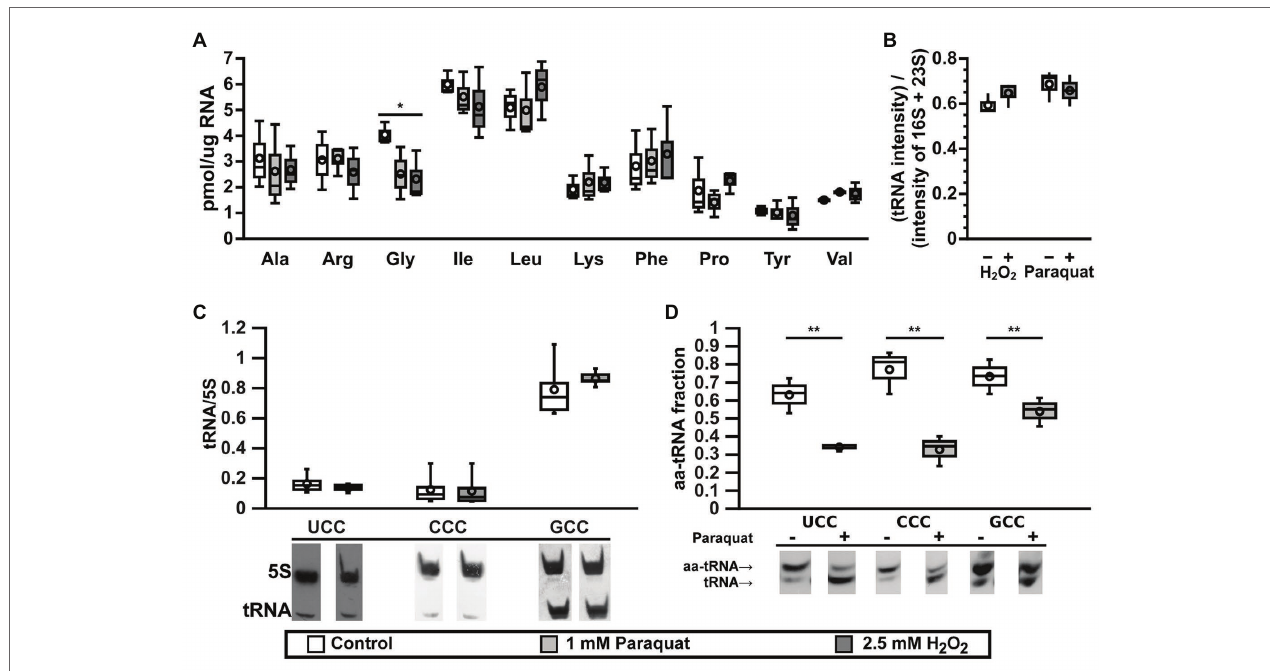
FIGURE 1 | tRNA Gly are inactivated under oxidative stress. (A) Effect of oxidative stress on the levels of active tRNAs specific for 10 different amino acids as measured by the plateau of aminoacylation reaction. Control: lysogeny broth (LB), white bars; oxidative stress: LB + 1 mM paraquat, light gray bars; or 2.5 mM H 2 O 2 , dark gray bars. * p ≤ 0.01, one way ANOVA with Dunnett versus Control posterior test for each amino acid ( n = 3). (B) Effect of oxidative stress on the levels of total tRNA from cells cultured in M9 media under control (white bars) or oxidative stress (gray bars, left: 2.5 mM H 2 O 2 or right: 1 mM paraquat) and analyzed by electrophoresis ( n = 3). Intensities from tRNA are higher than expected, as ribosomal RNA (rRNA) should represent at least 80% of total RNA. We suggest this is an artifact of staining efficiency and should not alter the conclusions of the figure. (C) Effect of paraquat on the levels of tRNA as quantified by Northern blot of total RNA samples purified from control (LB, white bars) or stressed (LB + 1 mM paraquat, gray bars) E. coli cells. Data in the graph showed no significant differences using one way ANOVA ( n = 5). (D) In vivo levels of aminoacylation of tRNA Gly in E. coli cell before (white bars) or 30 min after stress by 1 mM paraquat (gray bars). 3 ' terminal nucleotide of RNAs was eliminated by oxidation with sodium periodate followed by β -elimination and analyzed by Northern blot. ** p ≤ 0.05, paired t -test ( n = 3). In all box graphs, top, middle, and bottom lines of the box represent 25, 50, and 75% of the population. Whiskers represent the maximum and minimum values and the mean is represented by a